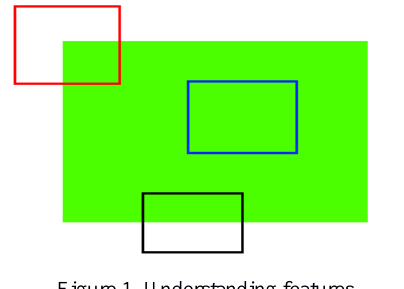
Figure 1. Understanding